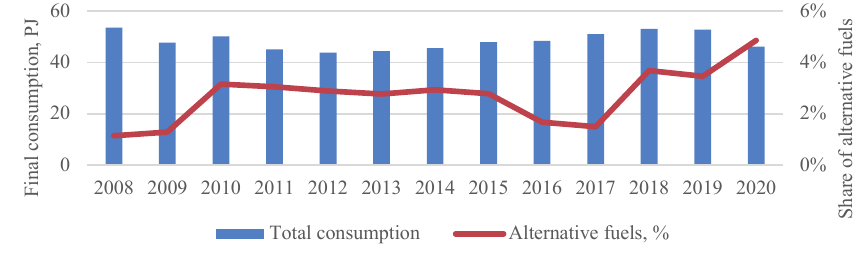
Fig. 1. Final energy consumption in the transport sector and share of alternative fuels from 2008 to 2020 [25]. Road transportation, which includes freight transport and passenger transport, has the highest energy consumption, accounting for more than 80 %